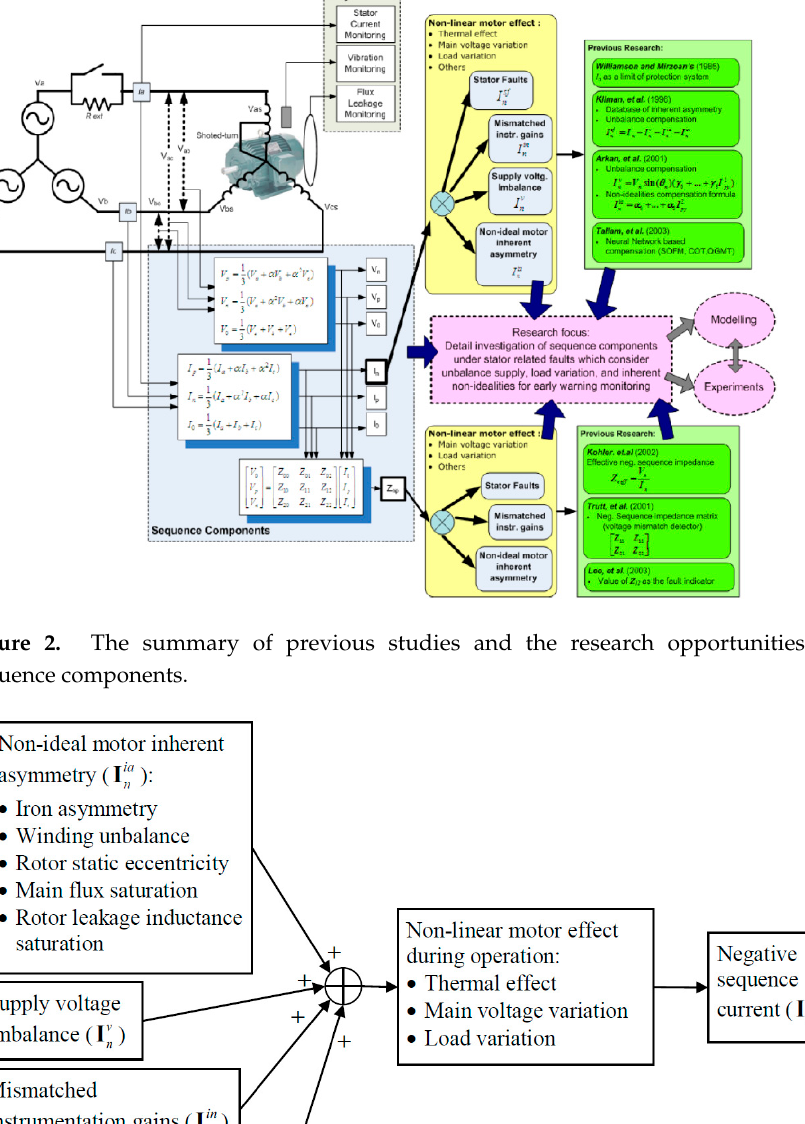
Figure 2. The summary of previous studies and the research opportunities for negative sequence components.